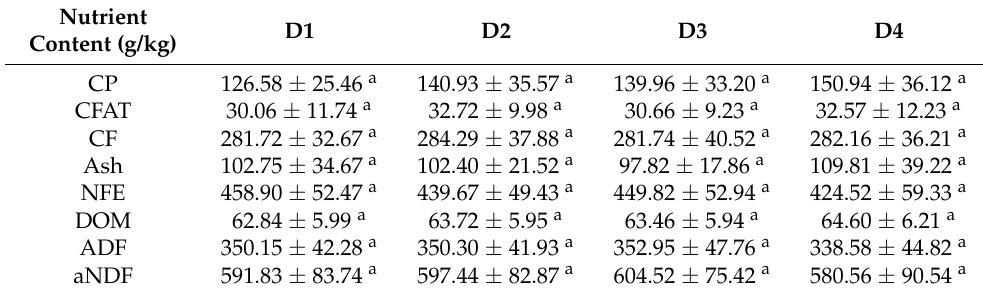
Table 9. Nutrient levels according to the fertilization regime (g/kg of dry